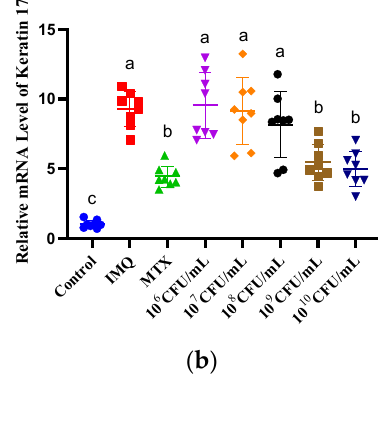
Figure 3. The dose–effect curve between CCFM683 dose and psoriasis indicators. ( a ) Ear thickness, ( b ) cumulative score, and ( c ) histological score of the skin. n = 8 mice per group.